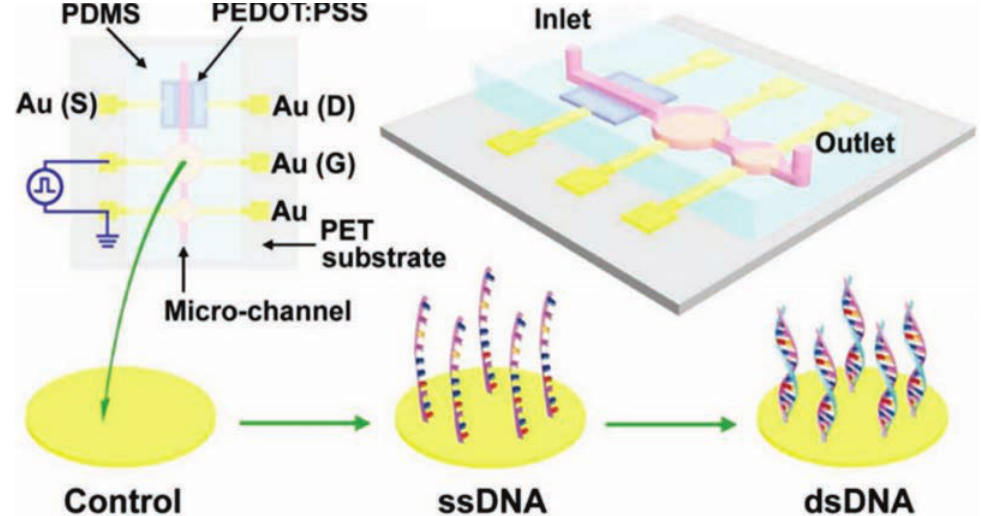
Figure 15. Schematic diagram of an OECT integrated in a flexible microfluidic system. Reprinted with permission from [ 74]. Copyright 2011 WILEY-VCH [